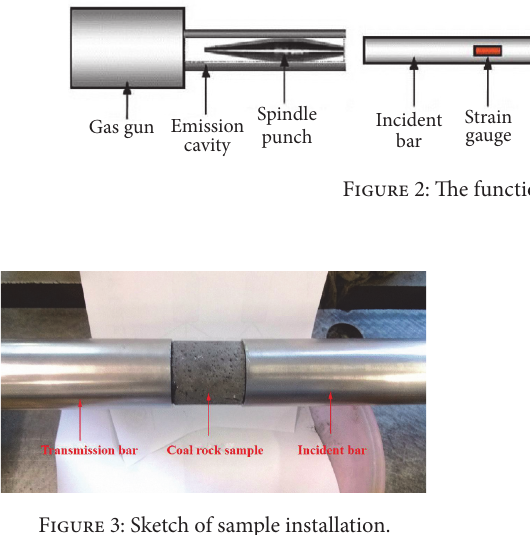
Figure 3: Sketch of sample installation.